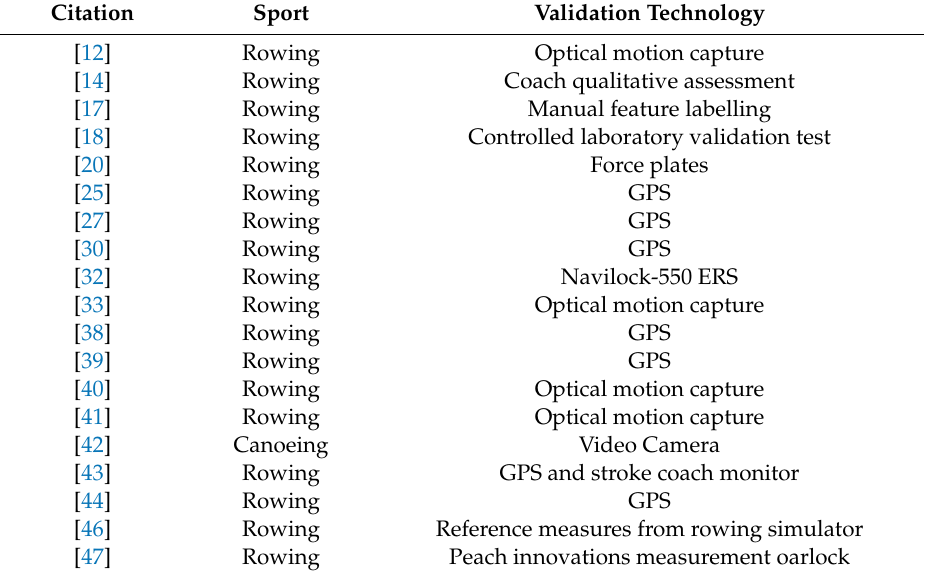
Table 6. Table of inertial sensor validation methods used in the included